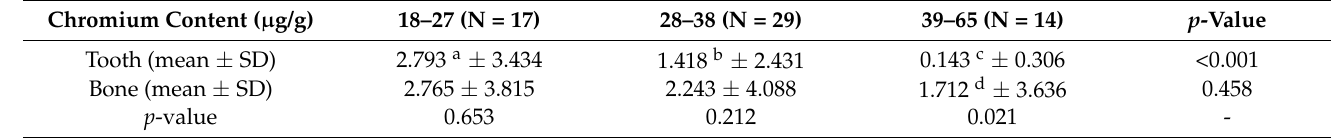
Table 17. Chromium content in tested samples taken from patients of different age.